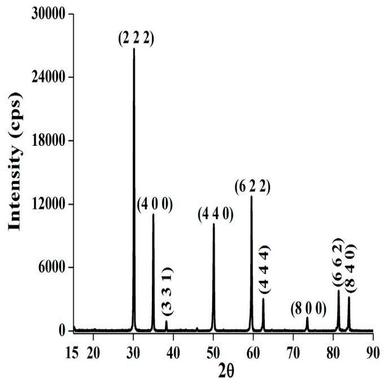
XRD pattern of Yb1.90Eu0.10Sn2O7.